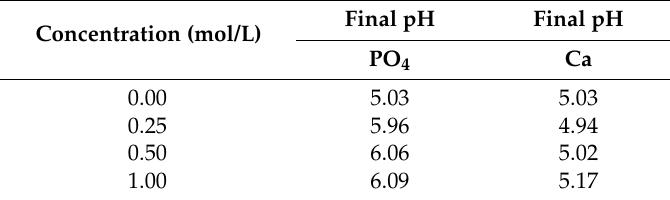
Concentration (mol/L)